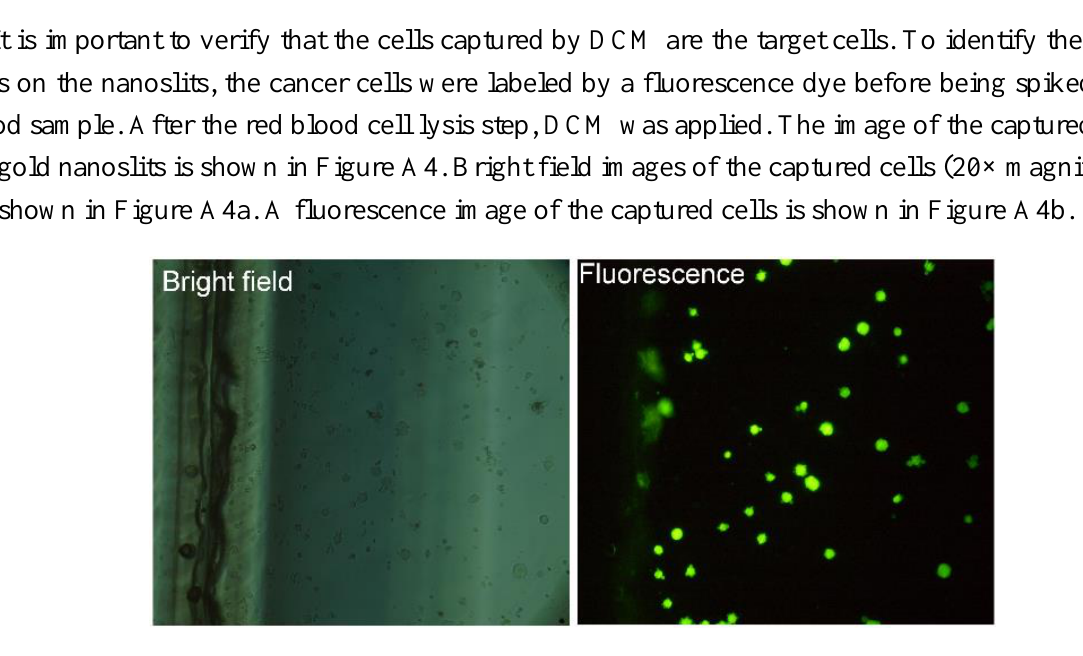
Figure A4. Identification of captured cells ( a ), the bright field images of the captured cells (20× magnifications). ( b ), the fluorescence image of the captured target cells (20× magnifications, exposure time 20